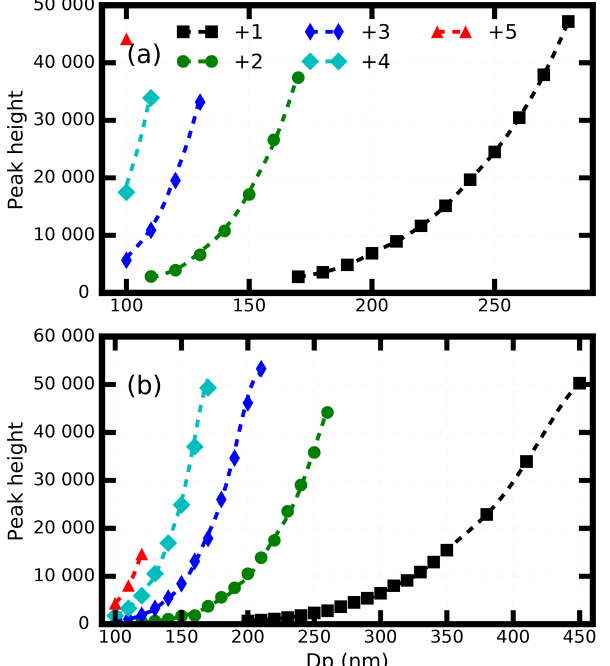
Figure 3. The geometric mean peak height for different diameters of the high-gain channel. The markers gives the measured values, and the dotted line shows the theoretically calculated value. Differ- ent colors represent the different number of elementary charges.